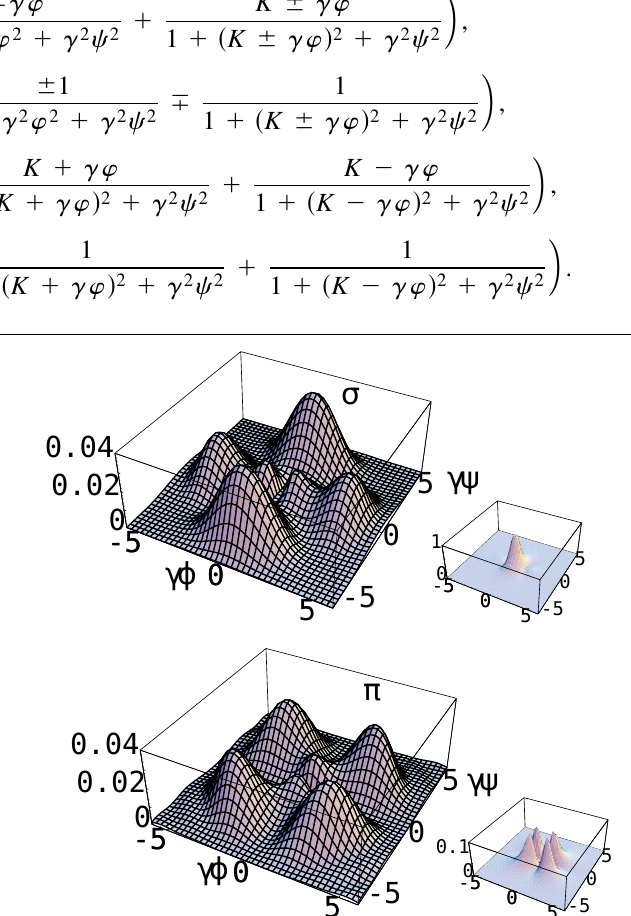
FIG. 7. (Color) Low frequency density distributions from three- dipole wiggler [Eq. (22)]. The small boxes show the energy density from the central dipole alone, for